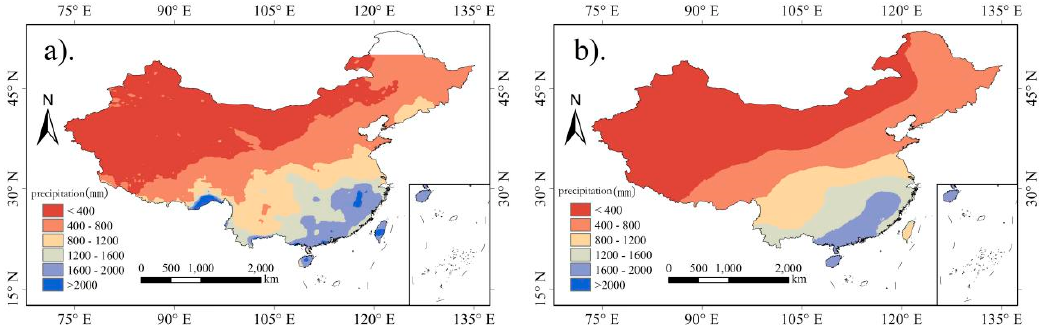
Figure 2. Annual average precipitation revealed by the 3B42V7 data ( a ) and rain gauge station data ( b ) in mainland China.